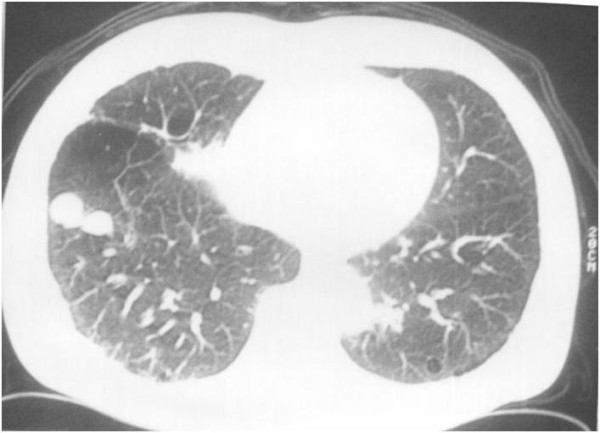
Two lung metastases.